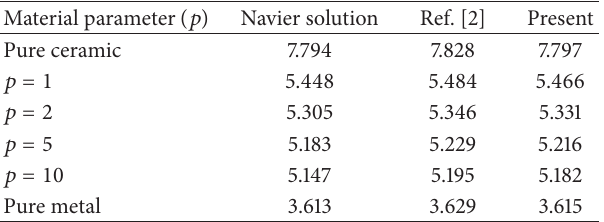
Table 7: Nondimensional buckling loads of FGM simply supported = 𝑁 𝑏 2 /𝐸 ℎ 3 ) . plates (𝑁 2 cr cr